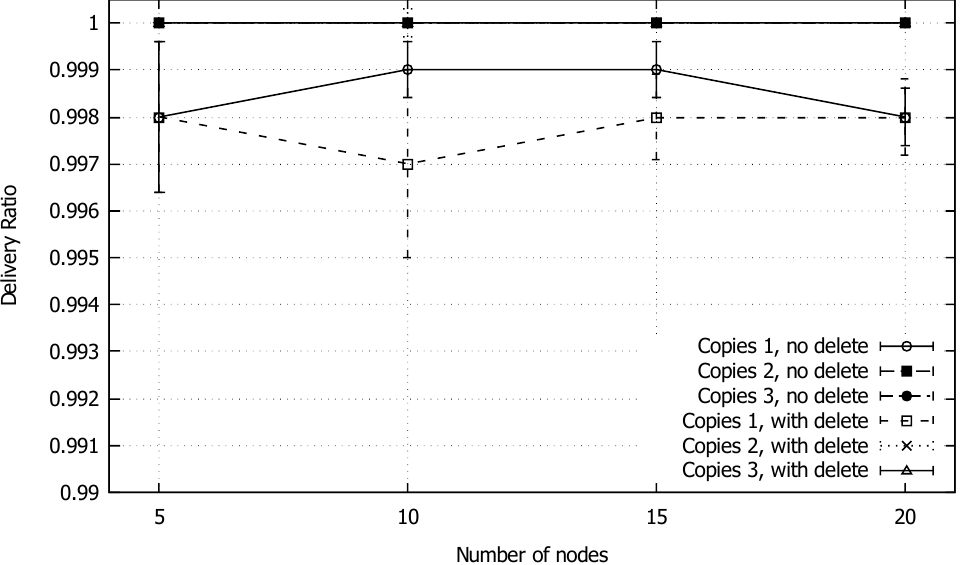
Figure 7. Average delivery ratio of GeoSaW with different parameters combinations when varying the number of